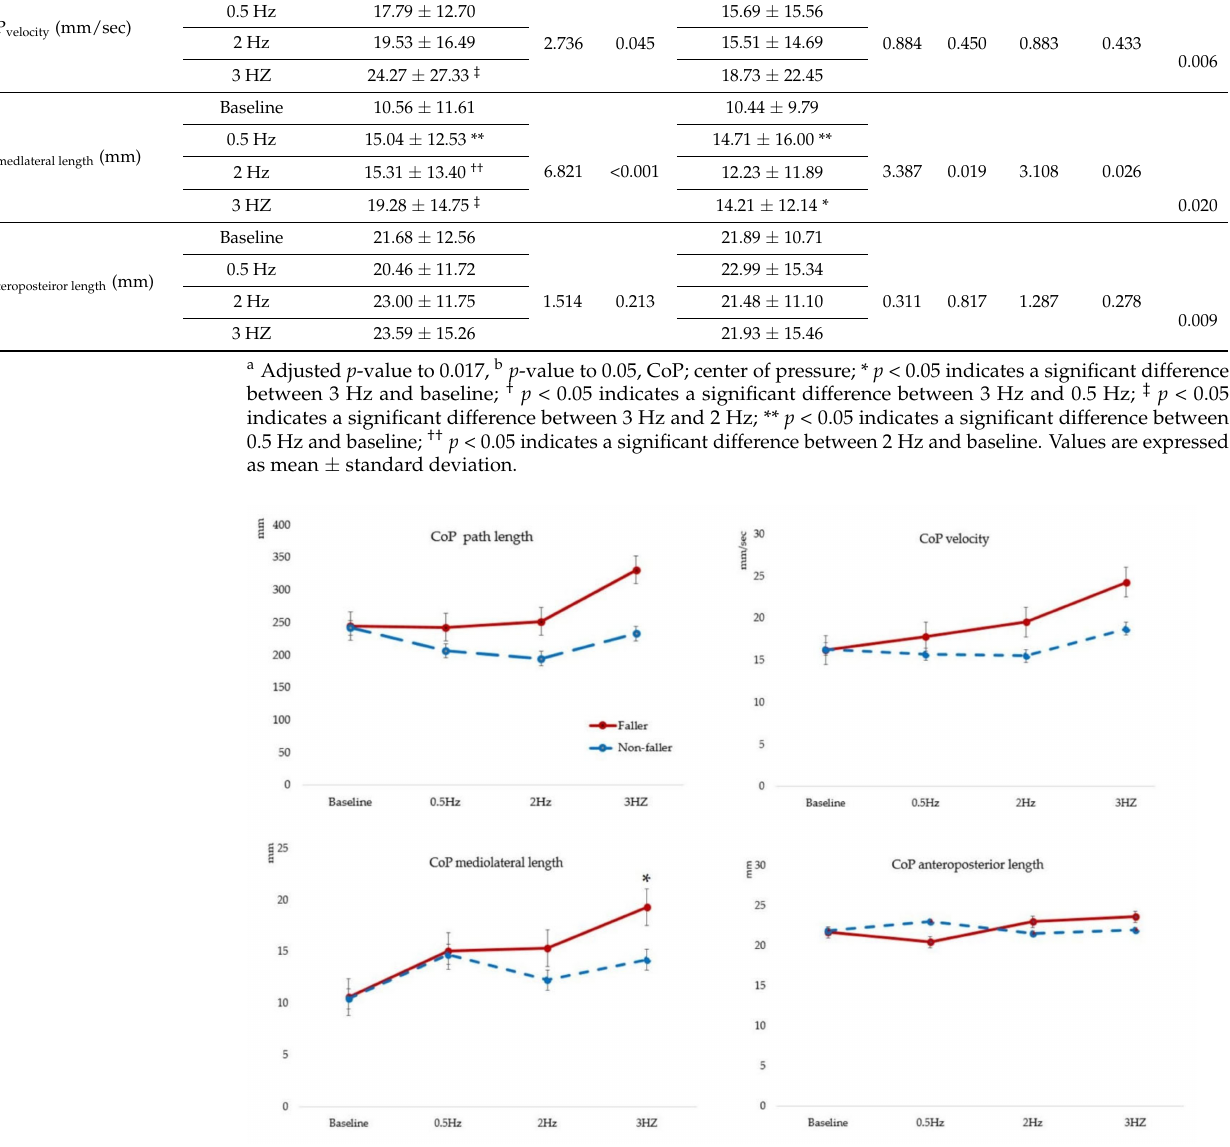
Figure 2. Comparisons of postural sway between baseline and during 0.5, 2 and 3 Hz saccadic eye movement. CoP; center of pressure, * p < 0.05 indicates a significant difference between the